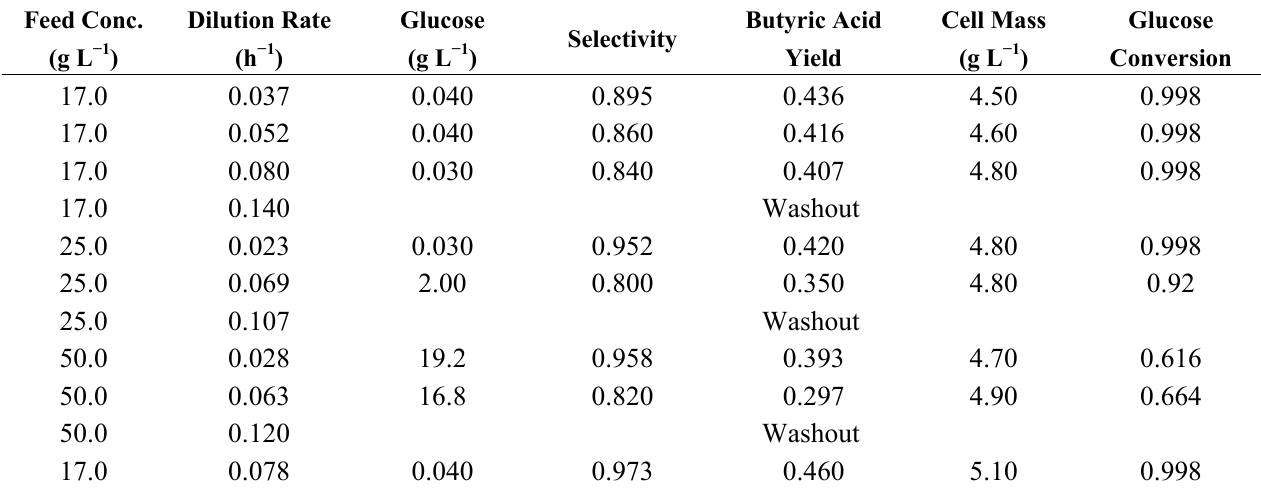
Table 1. Experimental results for continuous fermentation with and without cell recycle with Clostridium tyrobutyricum at pH of 6.2. Feed